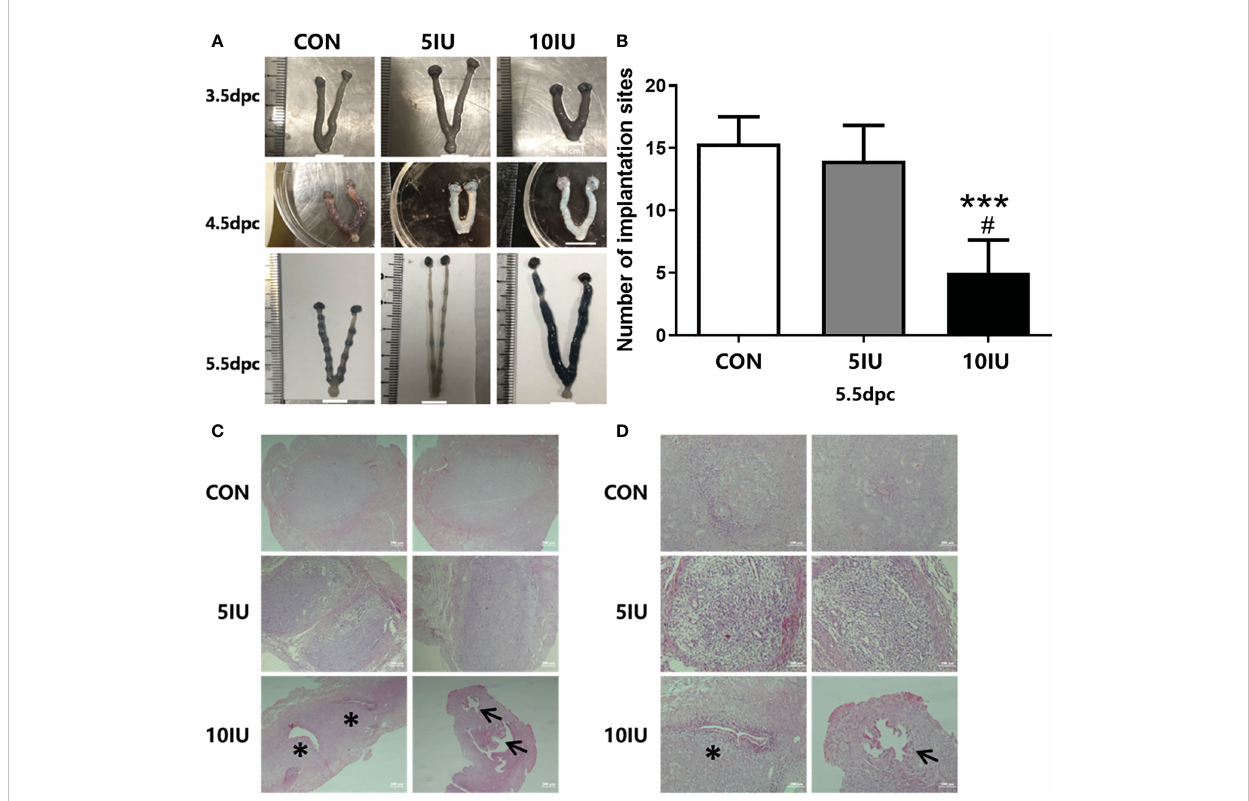
FIGURE 3 Uterine morphologies of mice during the peri-implantation period, implantation site numbers and implantation sites in the endometrium at 5.5 dpc among the CON, 5 IU and 10 IU groups. (A) Morphological changes in the mouse uteri from 3.5-5.5 dpc. A: Morphological changes in the uteri of mice from 3.5-5.5 dpc among the three groups. The implantation sites were stained with trypan blue. (B) Comparison of the implantation site numbers among the three groups of mice at of 5.5 dpc. Compared with the CON group, ***p<0.001. Compared with the 5IU group, # p<0.05. (C) Implantation sites in the endometrium at 5.5 dpc among the CON, 5 IU and 10 IU groups. Bar=200 m m. (D) Implantation site in the endometrium at 5.5 dpc among the CON, 5 IU and 10 IU groups. Bar=100 m m. ***p<0.001, *p<0.05. The arrows indicate abnormal sites of embryo implantation. The asterisk indicates the site of